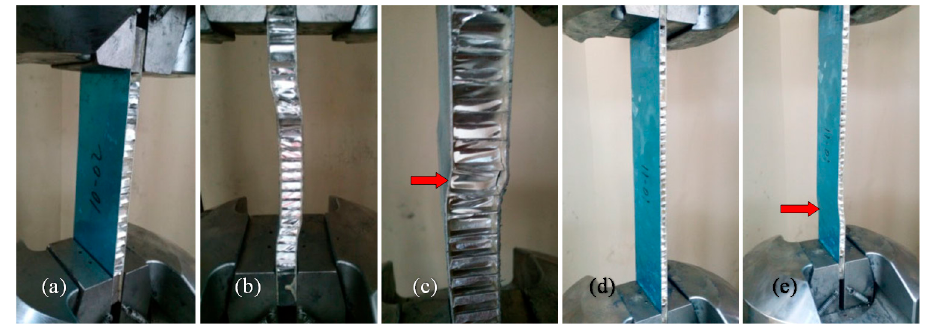
Figure 2. Damage processes in the ( a – c ) thick panel and ( d , e ) thin panel test pieces; ( a , d ) initial loading stage; ( b , e ) damaged condition; and ( c ) local magnification of ( b ).